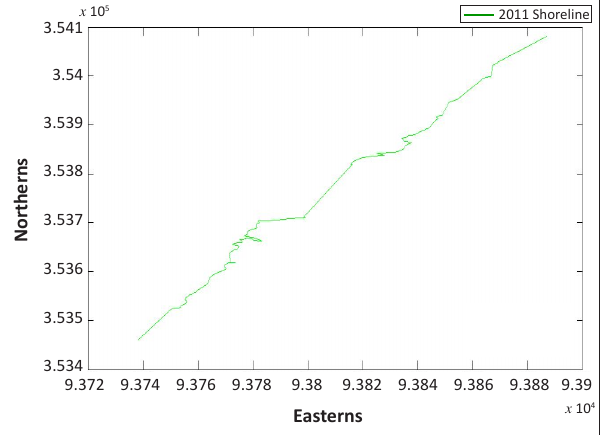
FIGURE 4 : Plot of shoreline proxy (high water line) data from RTK-GPS survey.